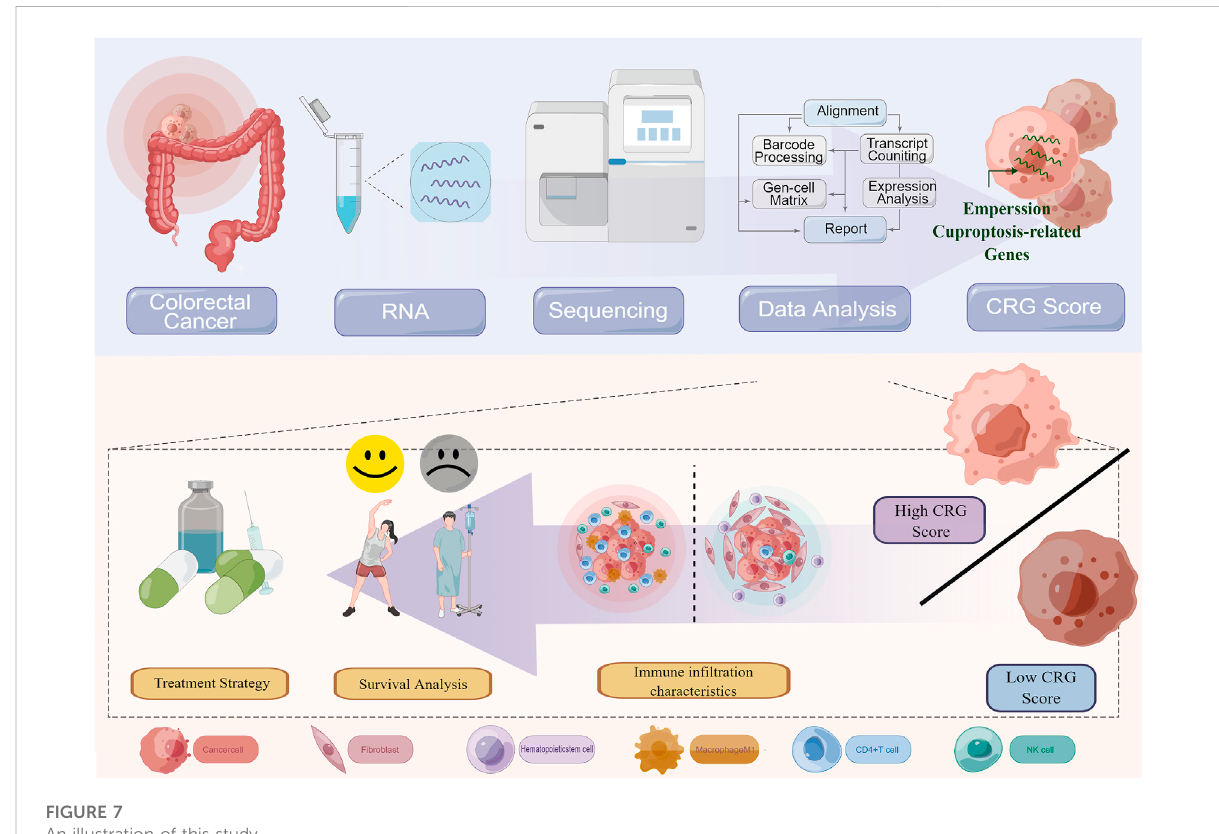
FIGURE 7 An illustration of this